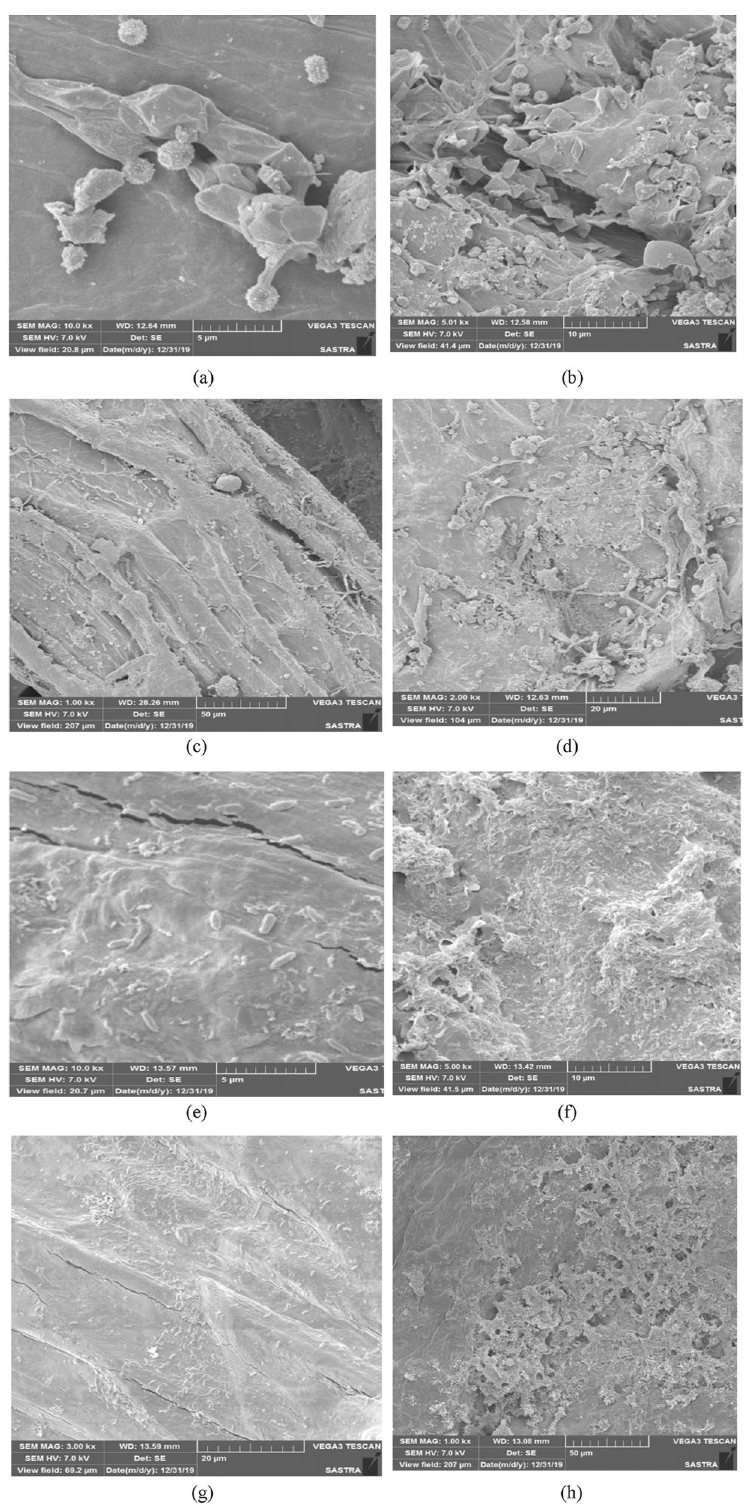
Figure 4. Surface morphology of Luffa ageyptiaca ( a – d ) before cells attachment; ( e – h ) After cells